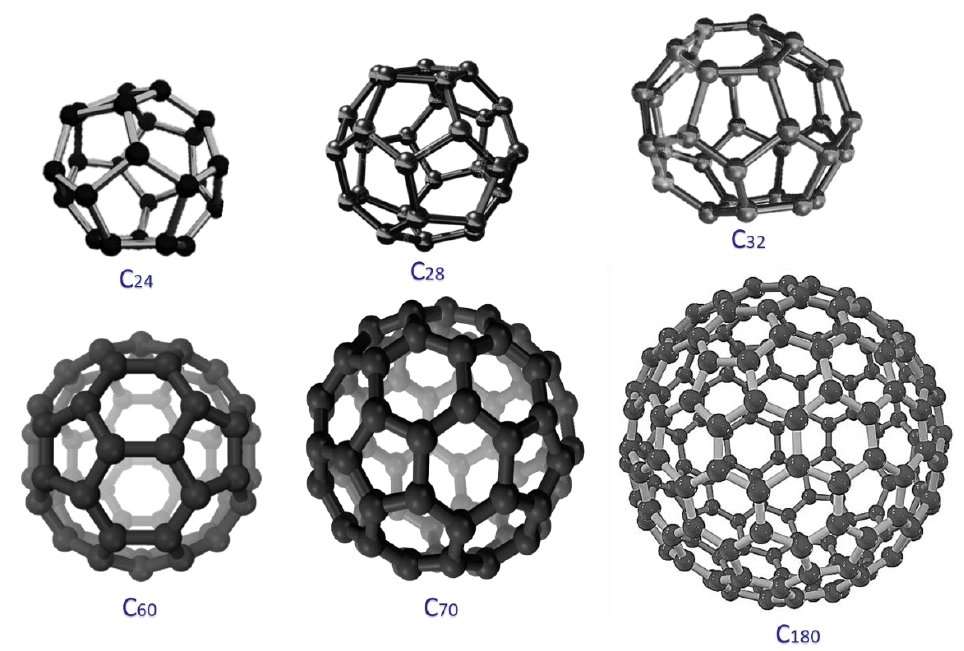
Figure 1. Fullerene nanostructures.